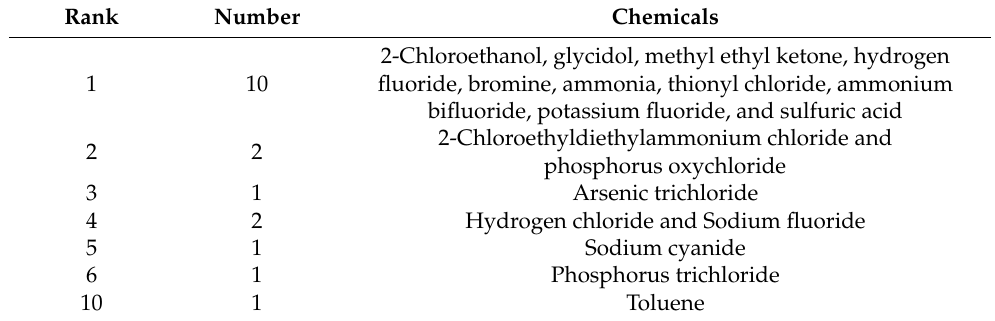
Table 3. Evaluation of recognition rate—Example identification using a characteristic spectral